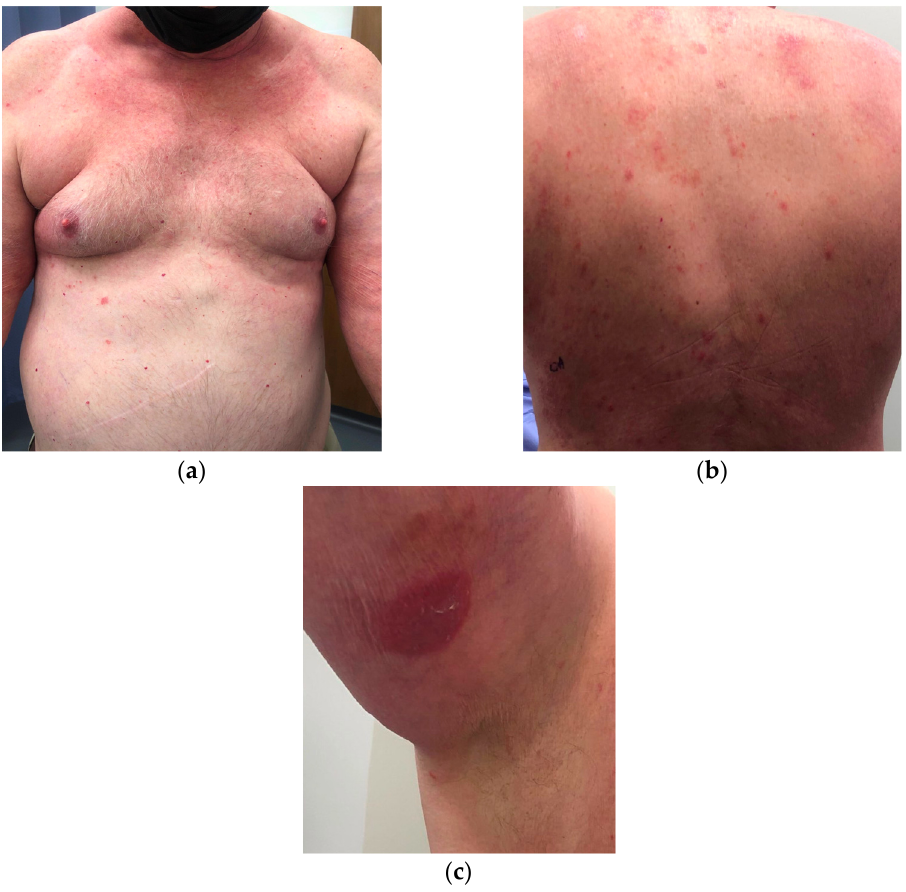
Figure 1. Clinical appearance of erythematous, poorly demarcated, faintly scaly plaques on the: ( a ) trunk; ( b ) and back. ( c ) A circular erythematous scaly-plaque on the upper-right inner